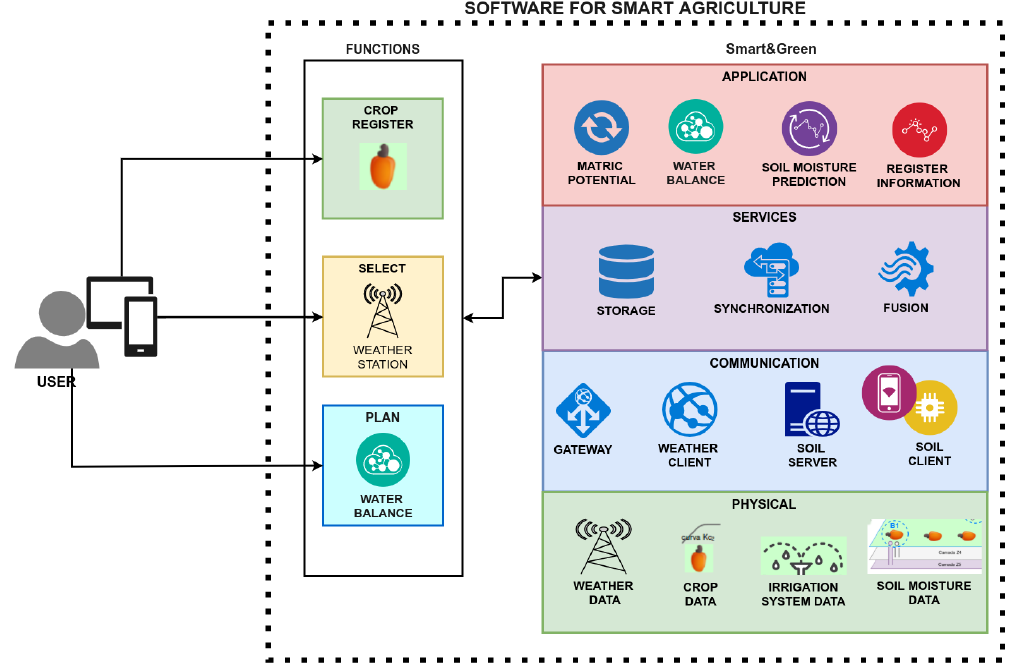
Figure 1. Conceptual architecture of the Smart&Green IoT Framework for Smart